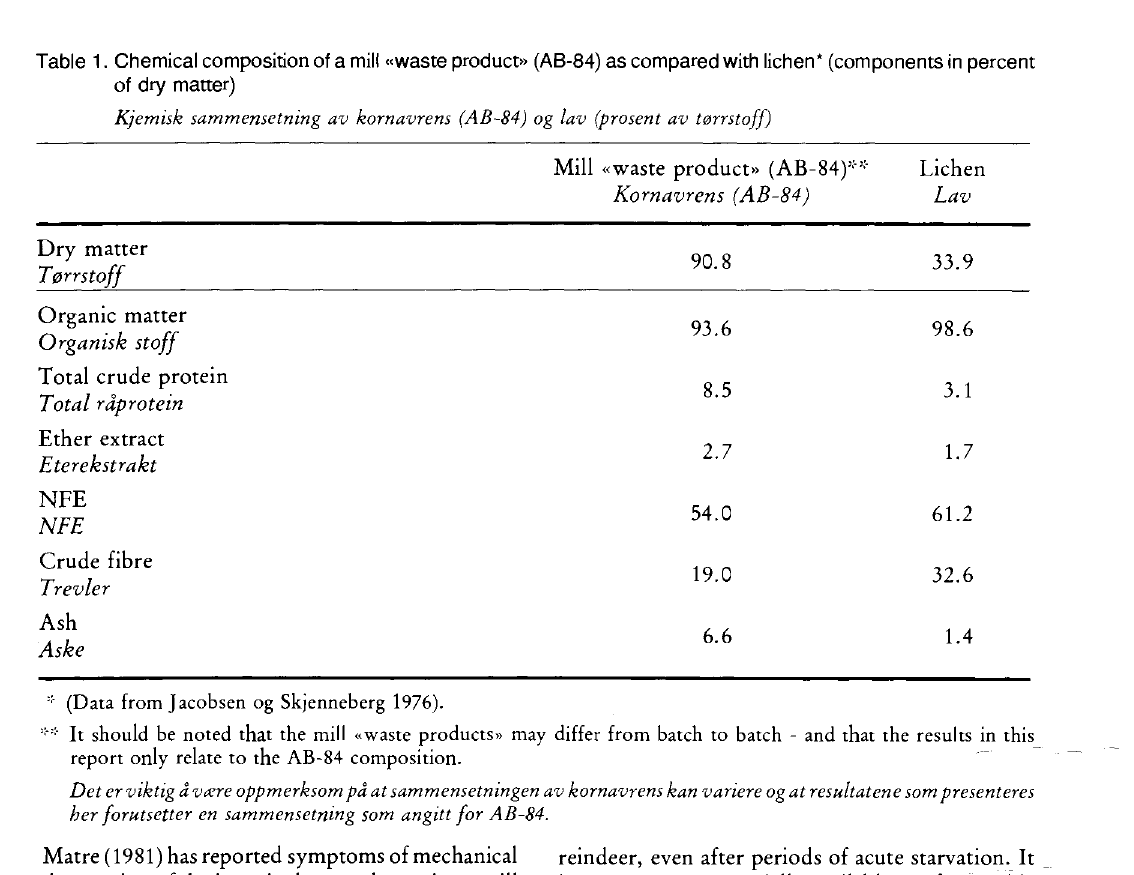
Table 1. Chemical composition of a mill «waste product» (AB-84) as compared with lichen* (components in percent of dry matter) Kjemisk sammensetning av kornavrens (AB-84) og lav (prosent av